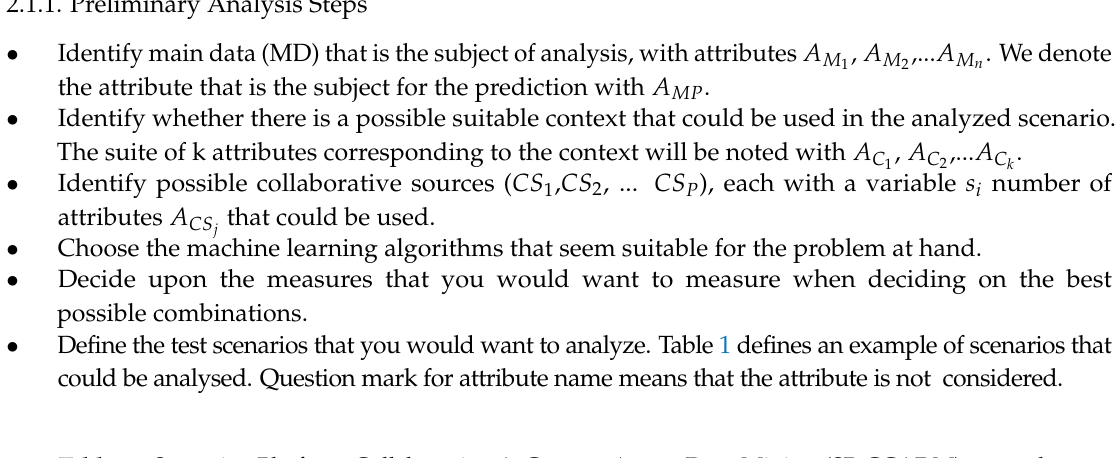
Table 1. Scenarios Platform-Collaborative & Context-Aware Data Mining (SP-CCADM) example: a hybrid CADM-CDM test scenarios to be covered in the analysis, where ? are ignored